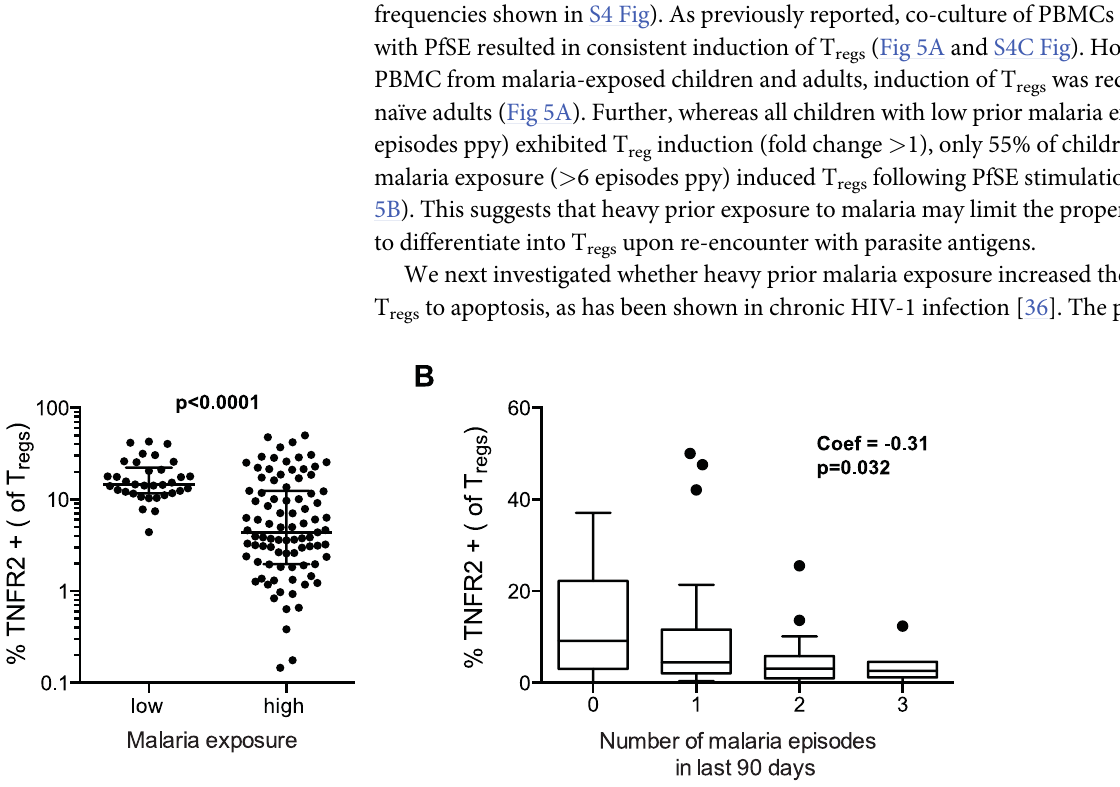
Fig 4. TNFR2 expression on FoxP3+ regulatory T cells declines with increasing prior malaria incidence. A. Frequencies of TNFR2 expressing T regs (FoxP3+CD25+CD127 dim ) were compared between children in the high malaria transmission area (Tororo District) and in the low transmission area (Jinja district). TNFR2 expression on T regs was higher in low compared to high transmission settings. Wilcoxon signed rank test indicated. B. The association between frequencies of TNFR2 expressing T regs and number of recent malaria episodes was analyzed among children from high malaria exposure area (Tororo District). TNFR2 expression declined with increasing number of malaria episodes in last 90 days. Regression coefficient and p value are